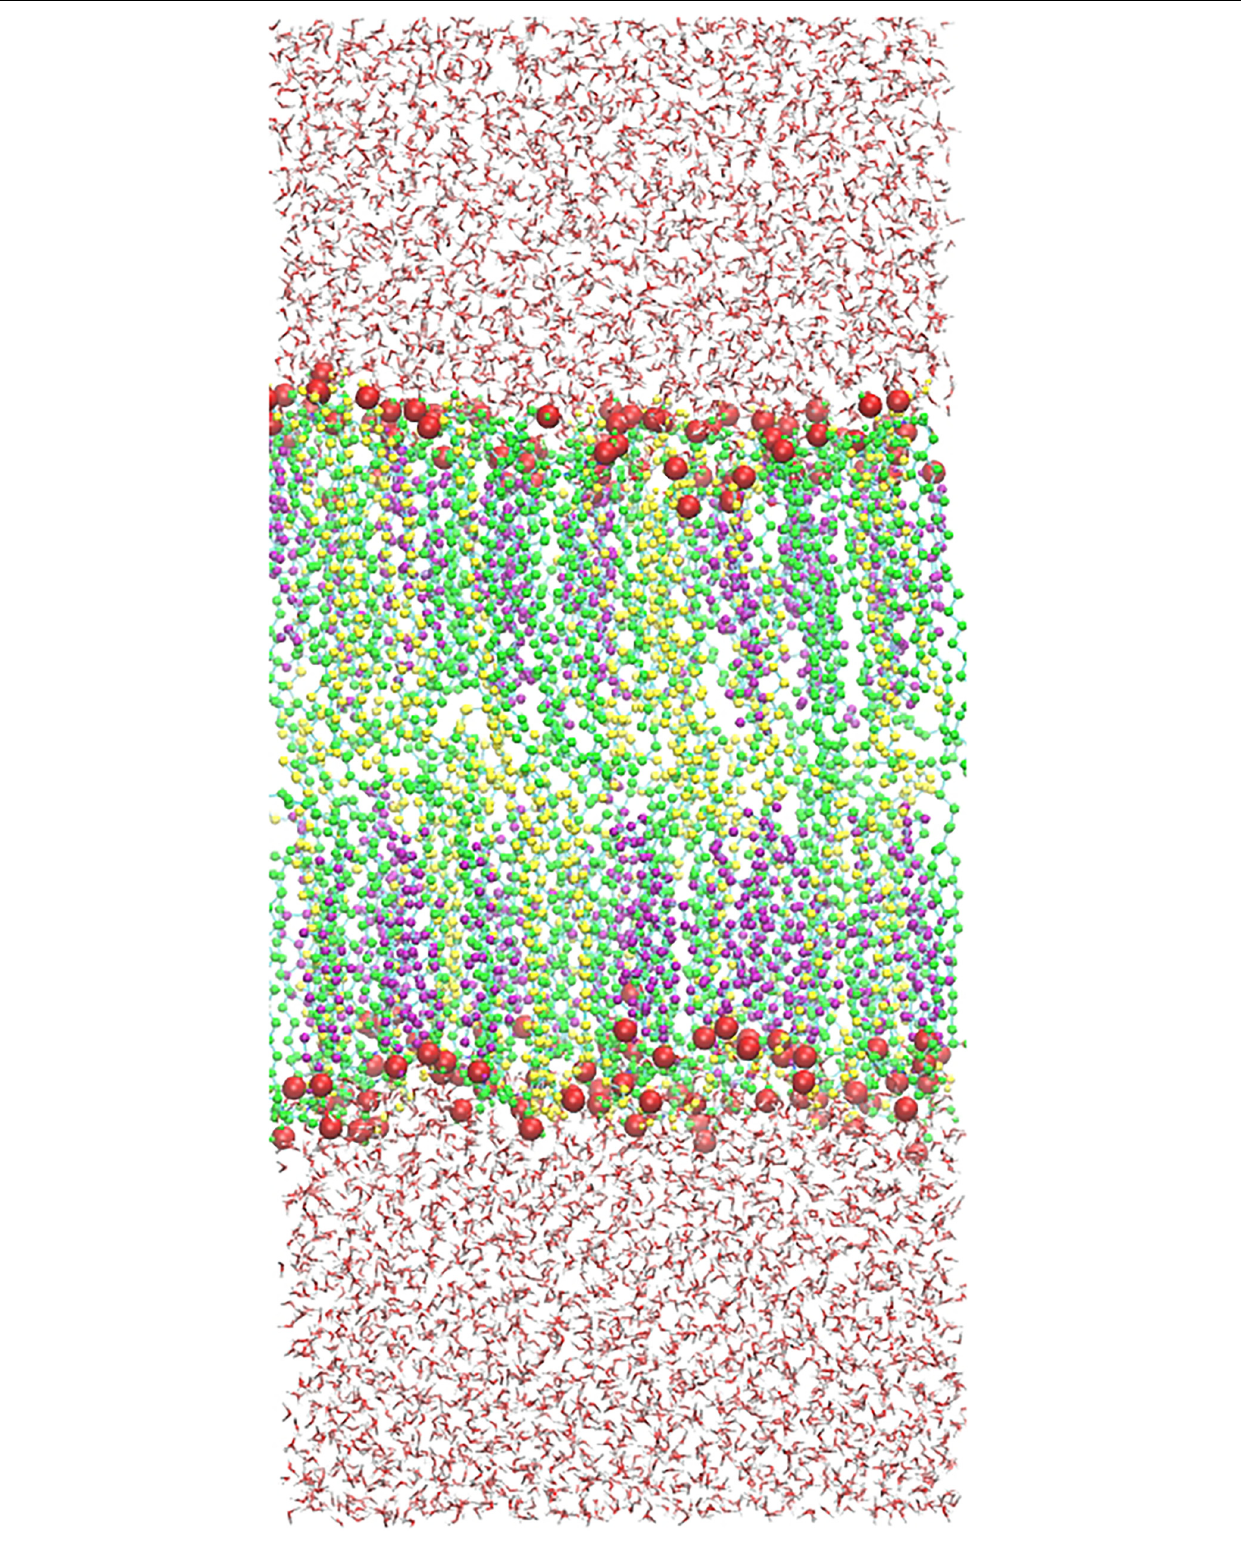
Frontiers in Pharmacology |